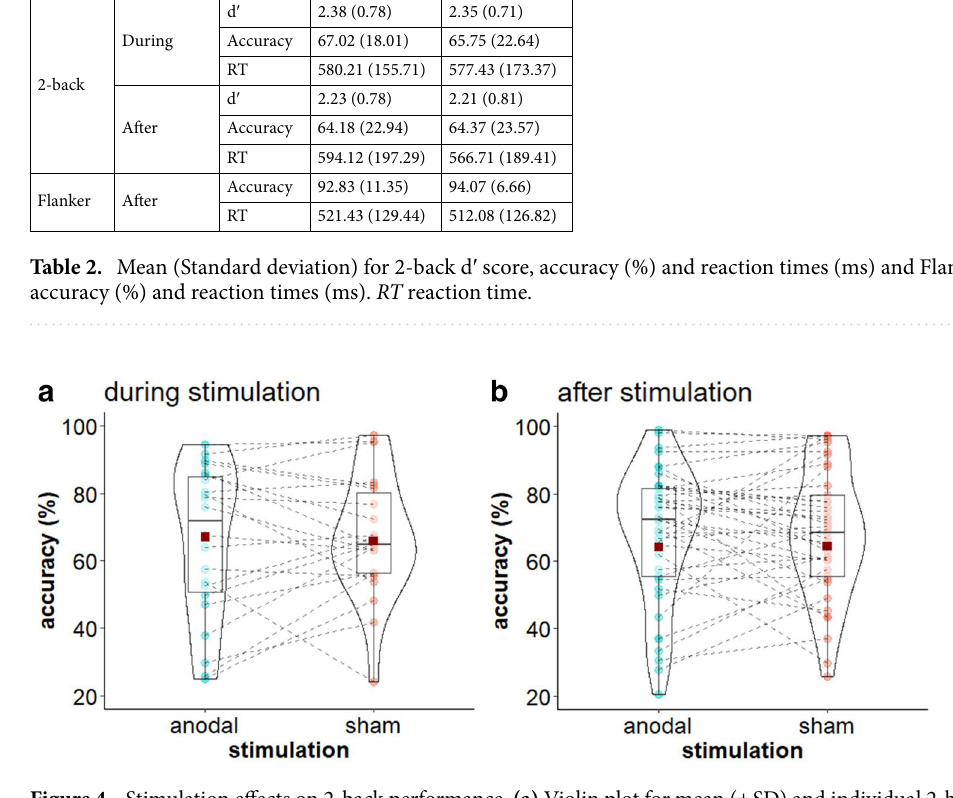
Figure 4. Stimulation effects on 2-back performance. (a) Violin plot for mean (± SD) and individual 2-back accuracy for sham and multichannel stimulation during stimulation. (b) Violin plot for mean (± SD) and individual 2-back accuracy for sham and multichannel stimulation after stimulation, averaged over concurrent and non-concurrent task condition. Red squares indicate mean accuracy, coloured dots indicate individual